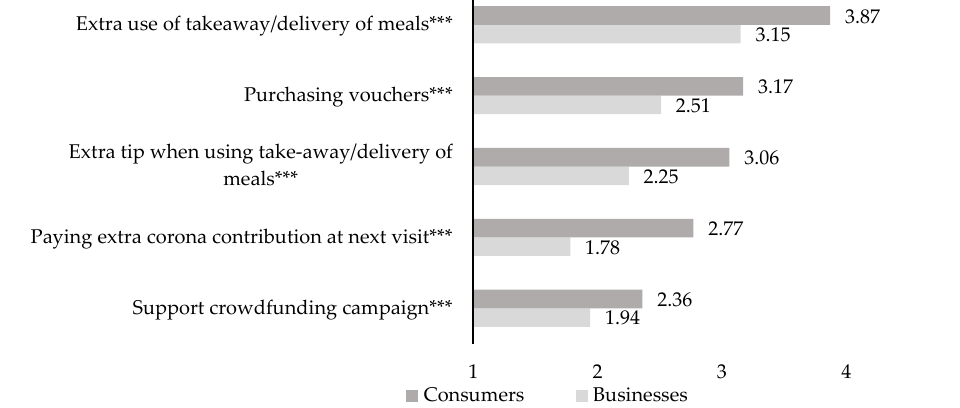
Figure 3. Consumers’ willingness to personally contribute ( n = 305) and businesses’ expectations of their customers’ willingness ( n = 253). Note: *** p < 0.001.